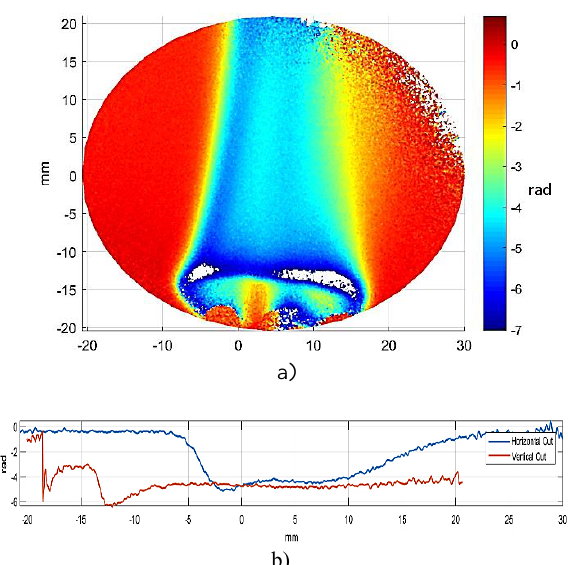
b) Fig.6. a) Corrected phase field map at some time instant from 𝜆 2 and b) plot of the phase profile run across the phase field horizontally and vertically through the origin axis Fig.6. represents the corrected phase map coming from 𝜆 based on (7). The phase field that had 2π jumps 2 is now corrected and represents visually a continuous phase map.